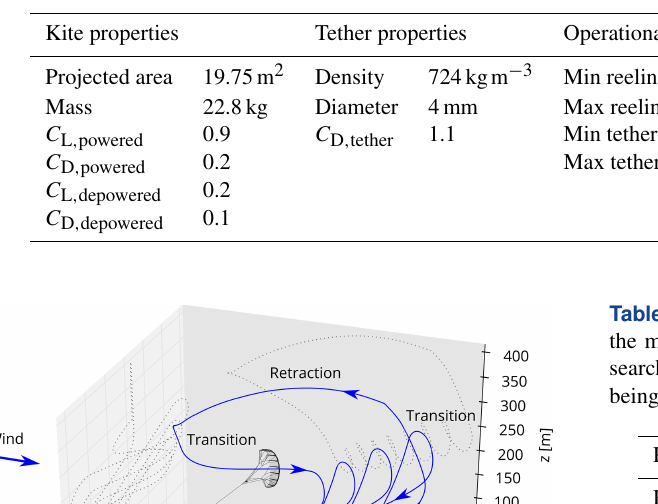
Table 4. Constant system properties that are required as model input for the QSM. C L and C D stand for lift and drag coefficients, respectively. The kite and tether properties follow from the work of Oehler and Schmehl (2019). The other properties are chosen by judgement of the authors for being representative for the analysed system.